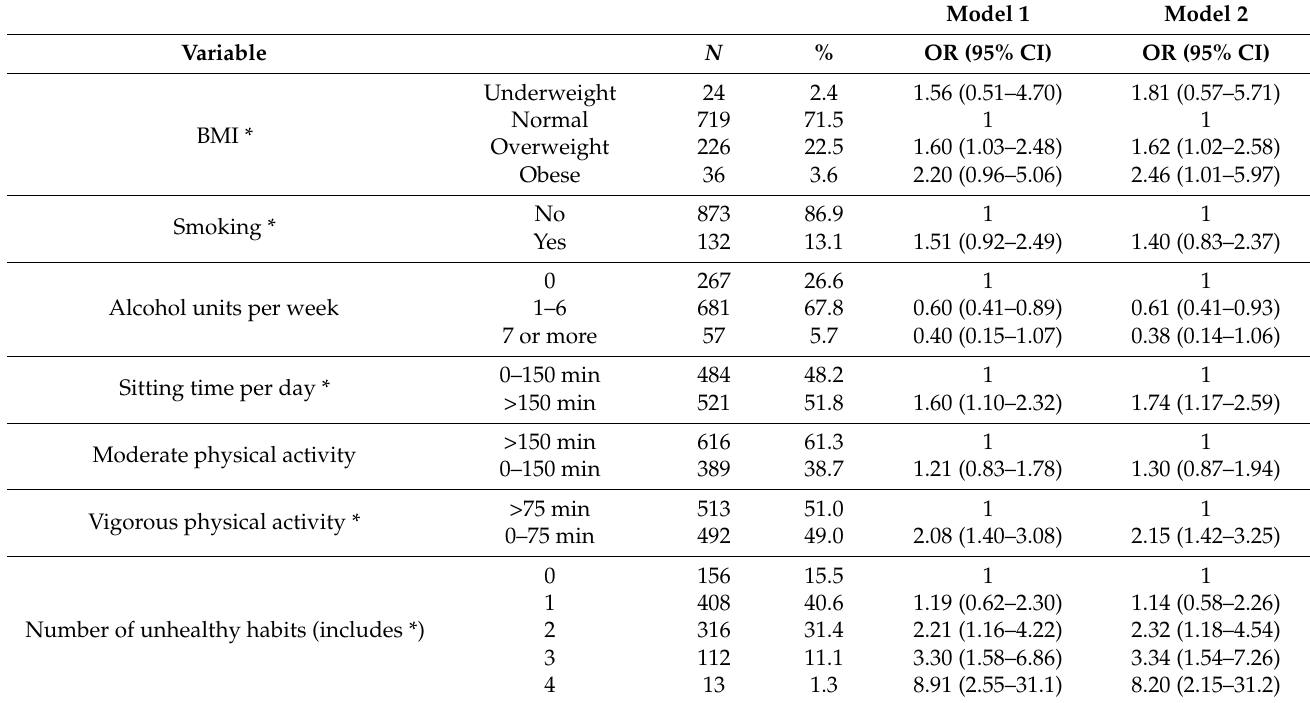
Model 1 Model 2